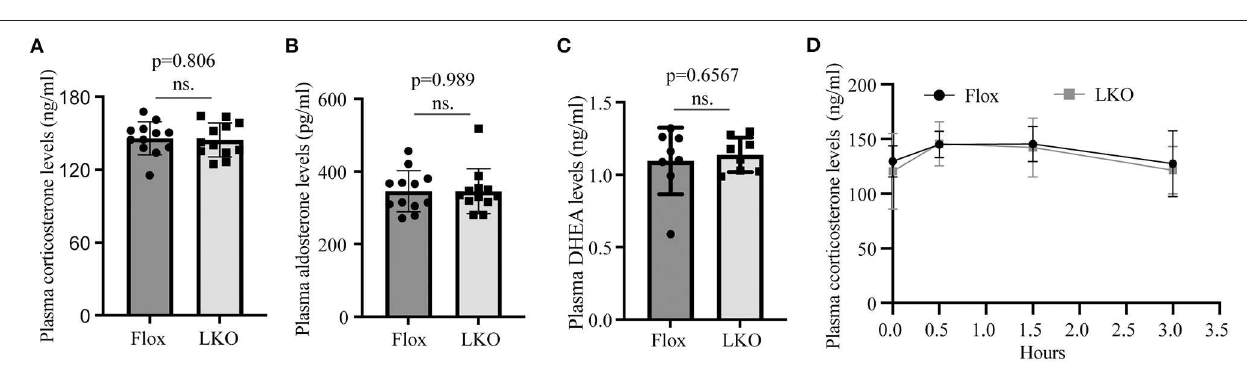
FIGURE 4 | Plasma levels of adrenal steroid hormones. (A–C) Fasting plasma hormone levels. Mice were fasted for 12h, and blood samples were collected for the measurement of corticosterone (A) , aldosterone (B) , and DHEA (C) with their specific ELISA kits. (D) Plasma corticosterone levels. Mice fasted for 12h were subjected to cold stimulation (4 ◦ C). Blood samples were collected at the indicated time points. Plasma corticosterone levels were measured using its specific ELISA kit ( n = 6). Values of all data were mean ± S.D. p > 0.05 was defined as no significant difference